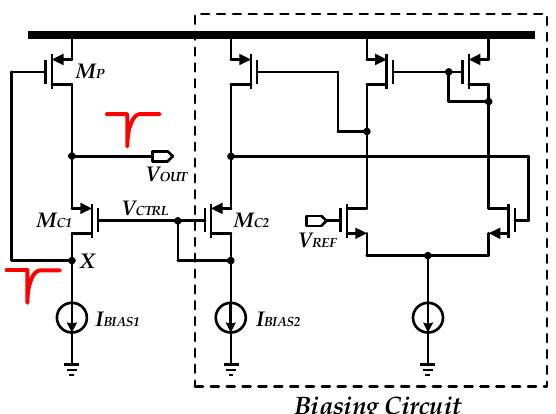
Figure 2. Flipped voltage follower (FVF)-based LDO regulator [12].